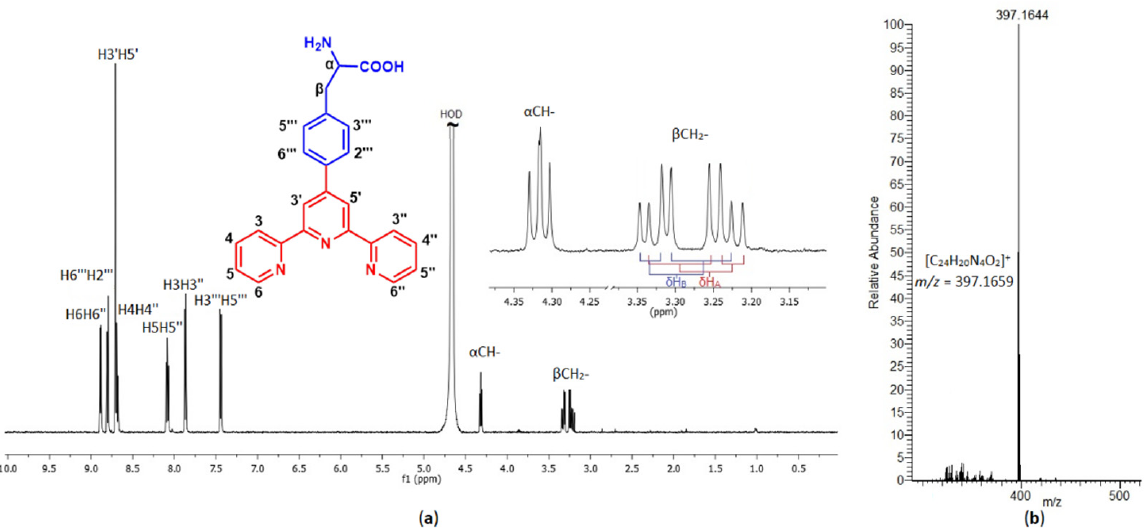
Figure 2. ( a ) The 1 H NMR spectrum (DCl 0.01 M, 298 K, δ ppm) of phet with structure numbering and proton assignments. Inset, expansion of the aliphatic part of the spectrum showing the ABX proton spin system between α C and β C. ( b ) The HRESIMS of phem.